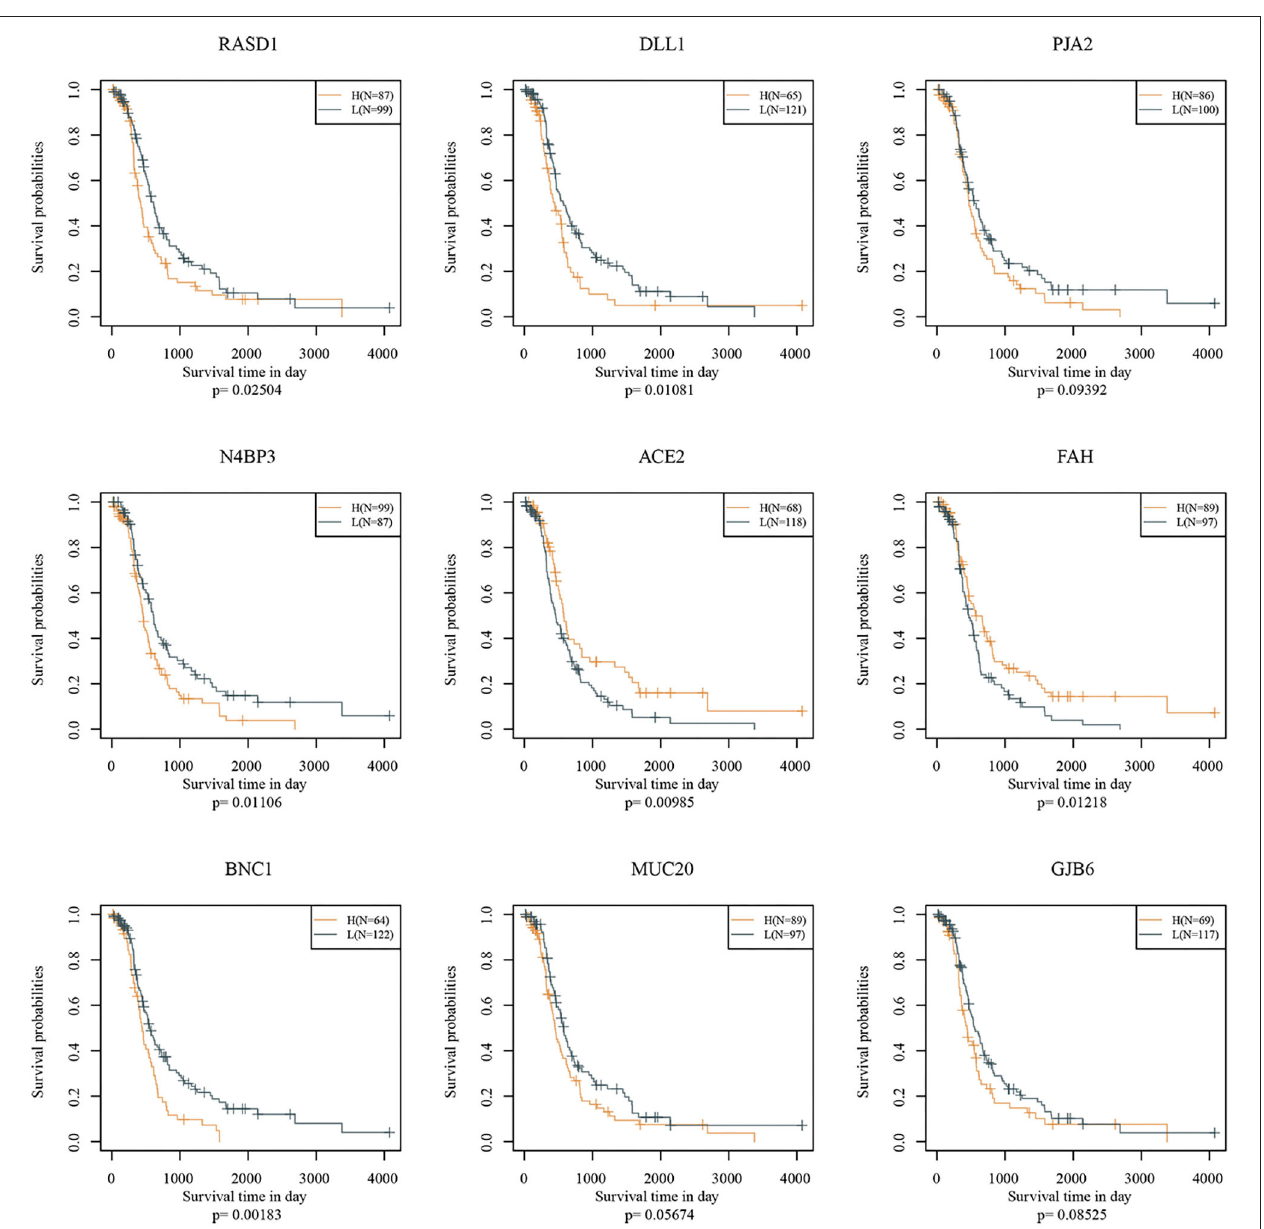
FIGURE 6 | Nine gene KM curves on TCGA training